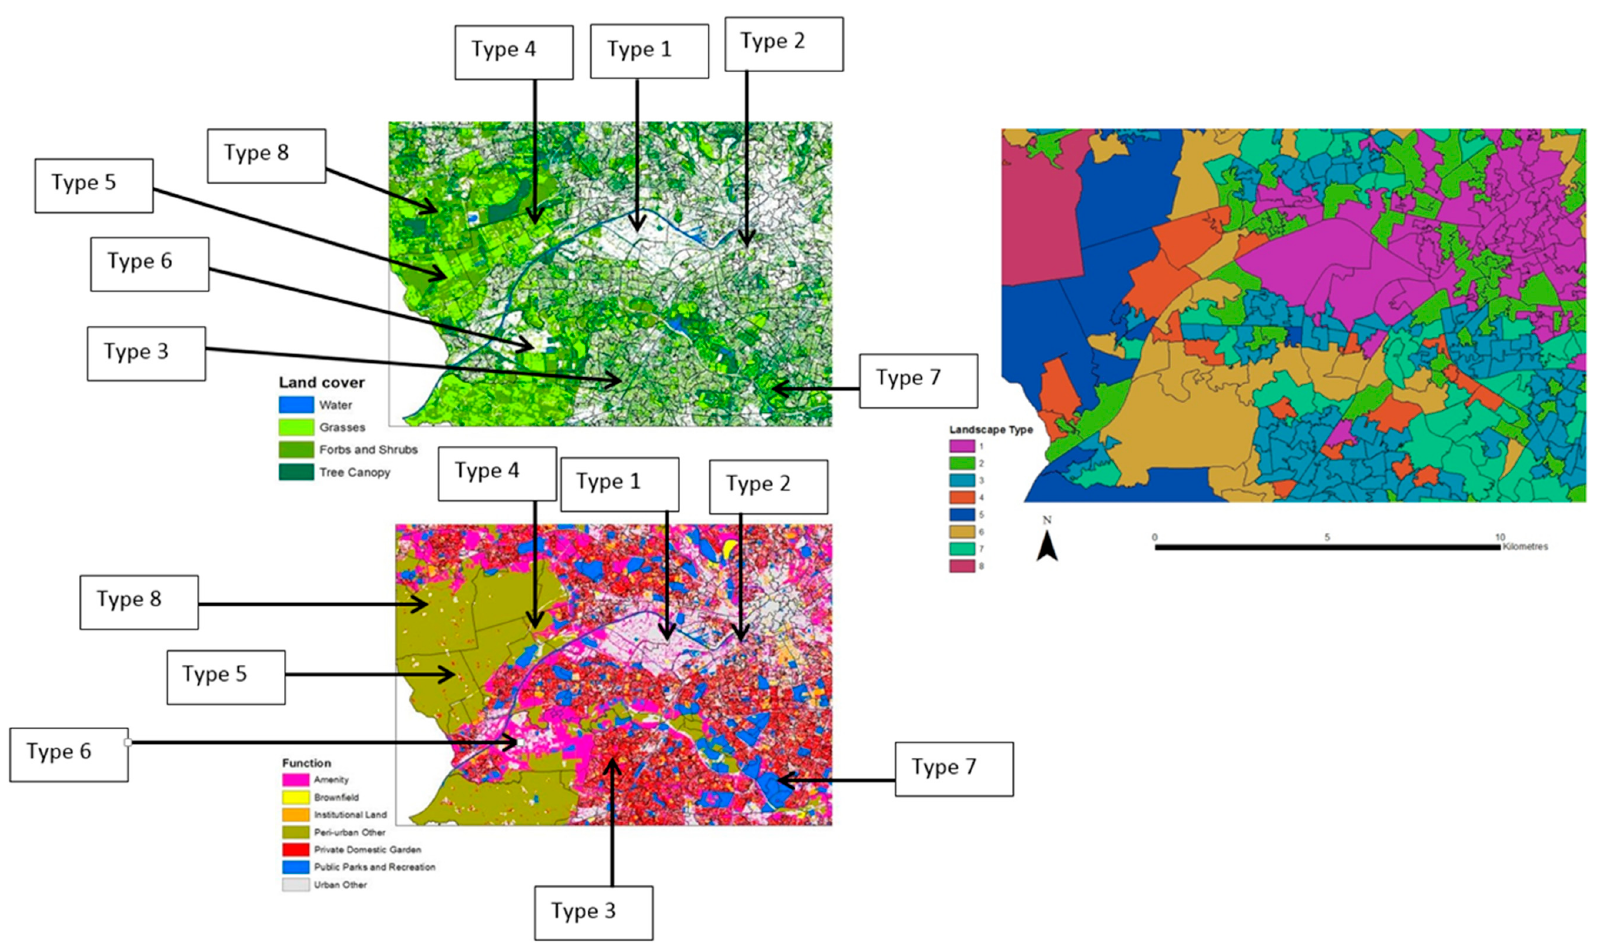
Figure 10. Examples of landscape types in the southwest of Greater Manchester. Source: LSOA boundary data from ONS, 2011. Key: Type 1: Dense Greyscape; Type 2: Garden City; Type 3: Leafy Residential; Type 4: Peri-urban Fringe; Type 5: Encapsulated Countryside; Type 6: Amenity Suburbs; Type 7: Parklands; Type 8: Rural Hinterland.